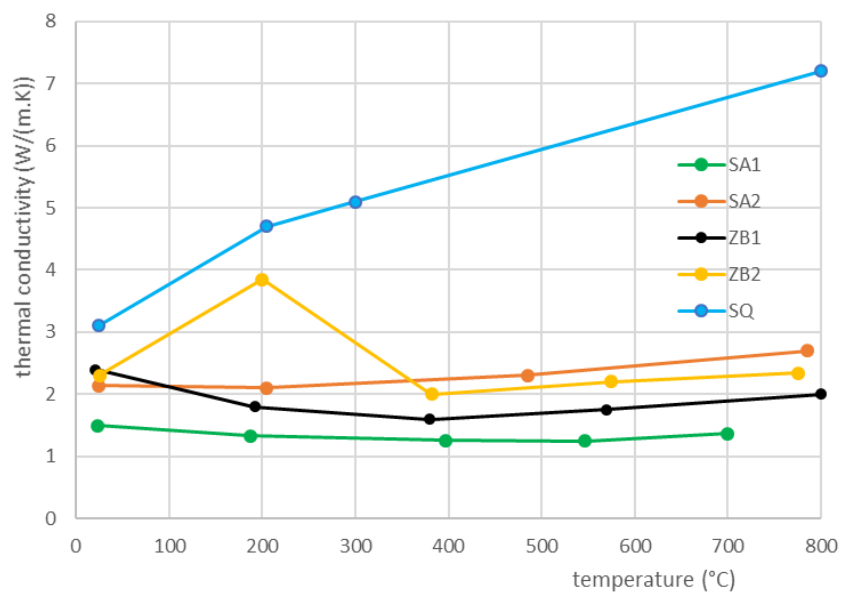
Figure 6. Change in thermal conductivity depending on the ambient temperature for the monitored cementitious composites.